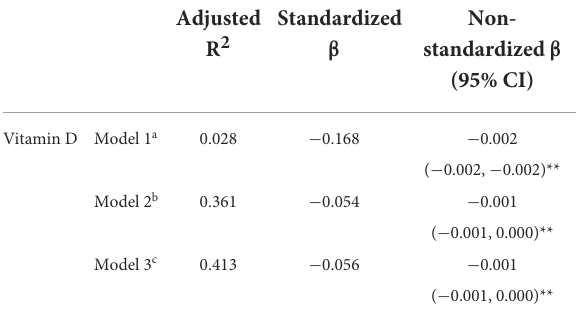
TABLE 3 Linear regression relationship for serum vitamin D and log-transformed HOMA-IR in